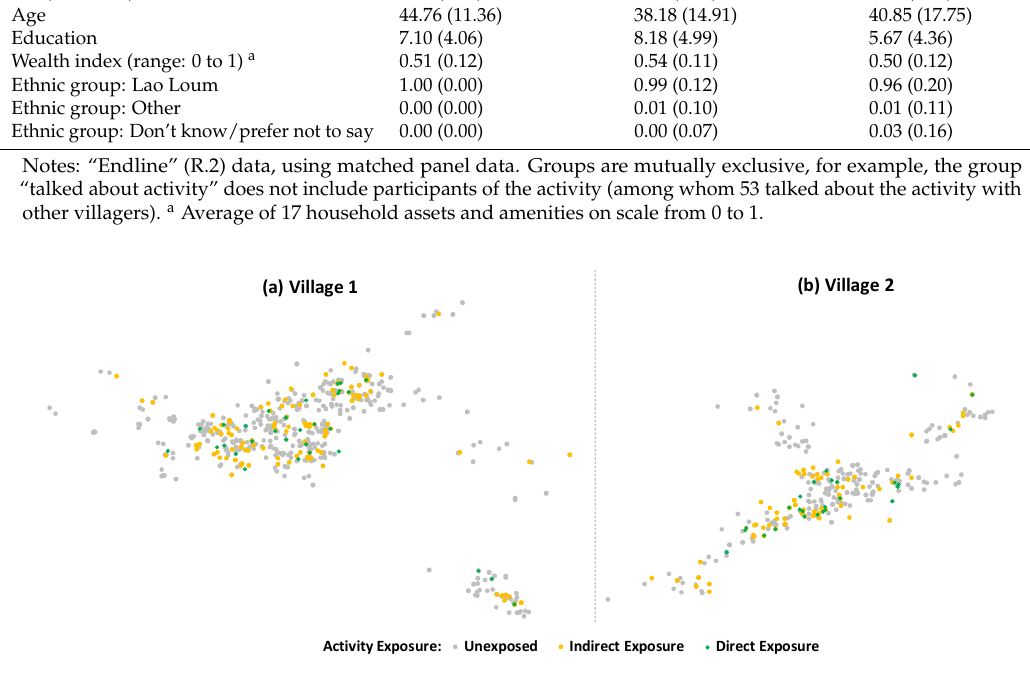
Figure 2. Map and overview of educational activity exposure in case study villages. Notes: “Endline” (R.2) data, using matched panel data. n = 723 (Panel ( a )), n = 407 (Panel ( b )). Marker size adjusted to distinguish overlapping responses.